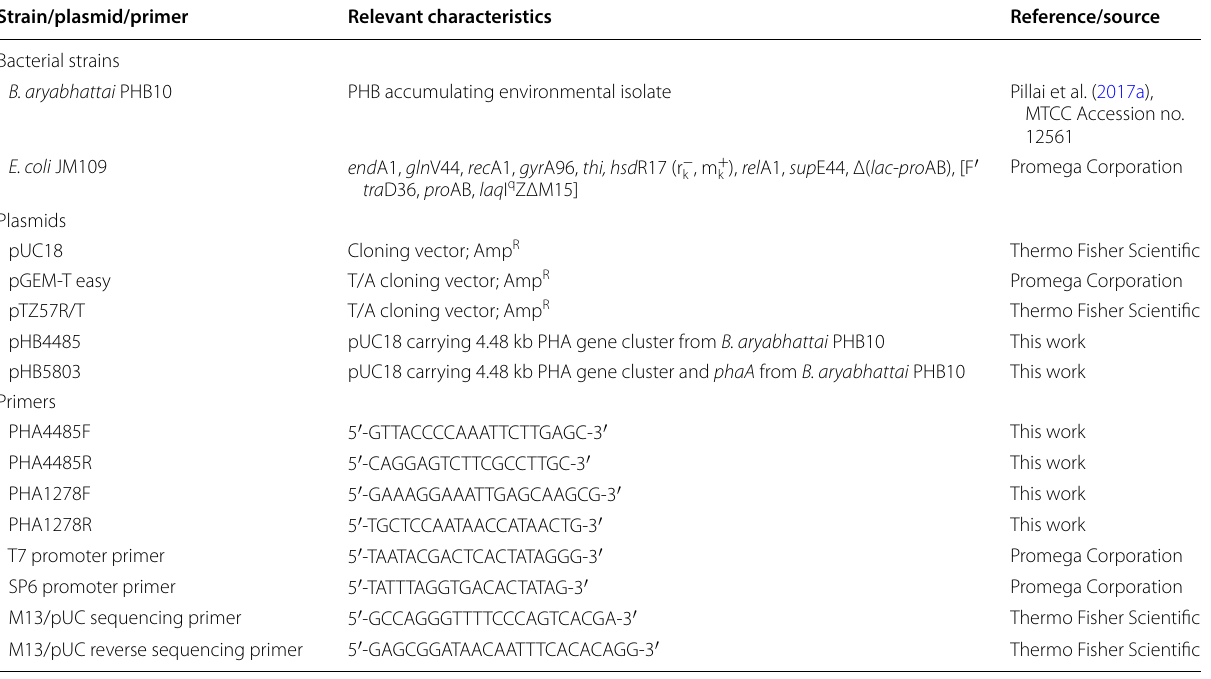
Table 1 Bacterial strains, plasmids and primers used in this study Strain/plasmid/primer Relevant